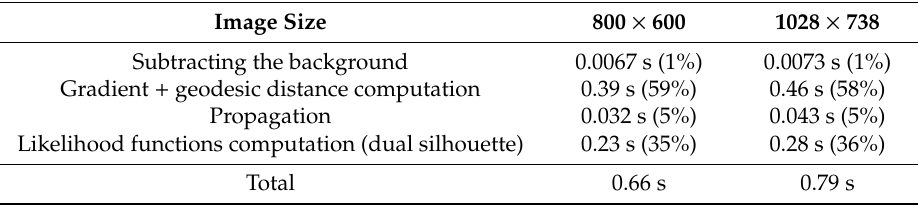
Table 4. Computation times for our 3D tracking algorithm (100 particles, m = 1).